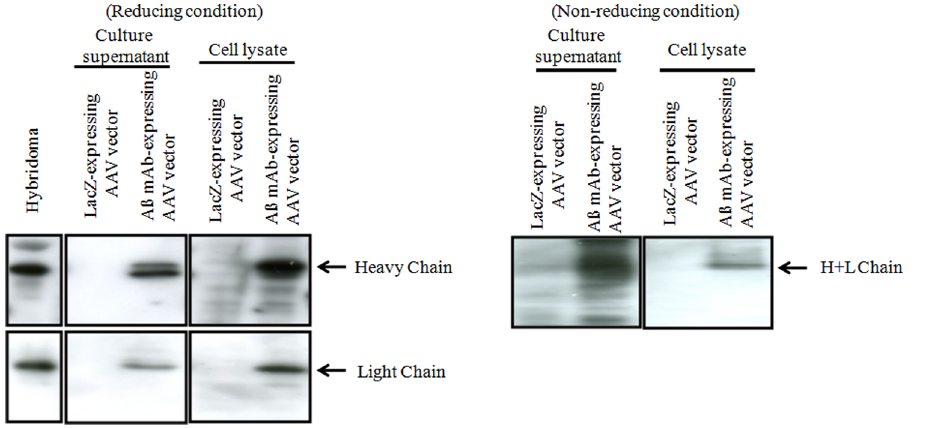
Figure 1. In vitro expression of anti - Aß Abs following the transduction of HEK293 cells with the Aß mAb – expressing AAV vector. Western blots of culture supernatant and cell lysates identify the Ig light and heavy chain (under reducing conditions) and whole Ab (under non- reducing conditions). Cells transfected with a LacZ encoding AAV vector served as negative controls.